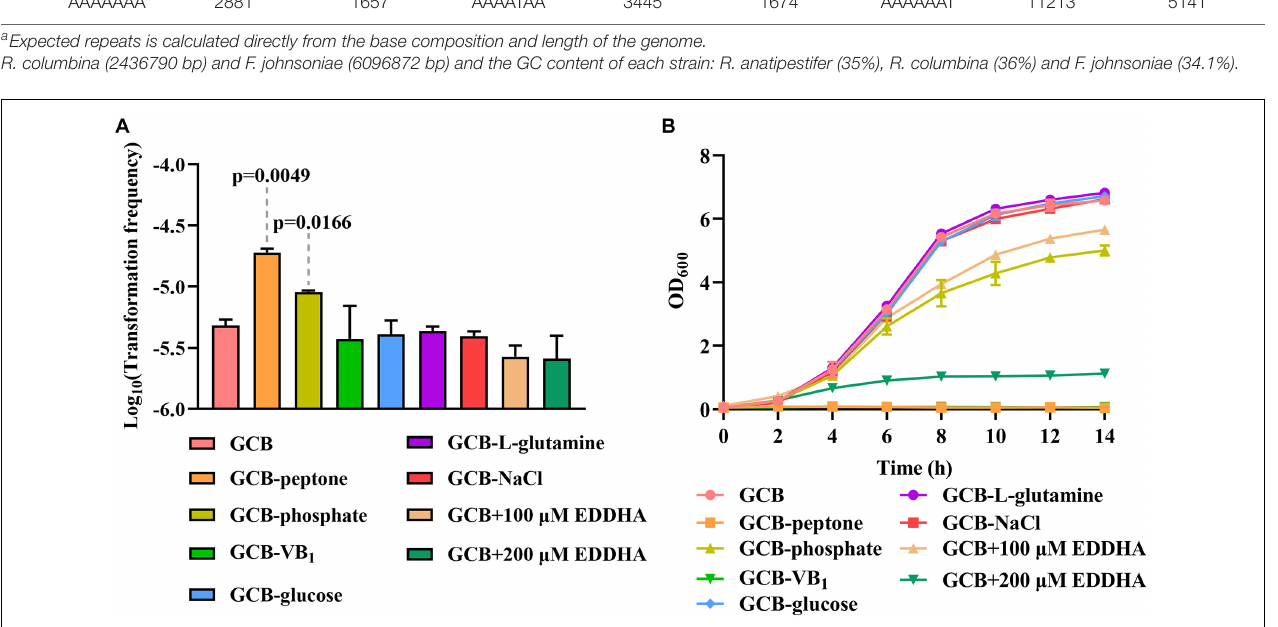
FIGURE 5 | The effect of GCB ingredients on natural transformation and growth in R. columbina . (A) TFs of R. columbina in GCB, GCB depleted of VB 1 , glucose, L-glutamine, NaCl, peptone or phosphate and GCB supplemented with different concentrations of EDDHA. The P -value refers to the difference between the TF in GCB and in GCB depleted of peptone or phosphate, respectively. Insignificance p -value ( P > 0.05) was not shown. (B) Growth curves of R. columbina in GCB, GCB depleted of VB 1 , glucose, L-glutamine, NaCl, peptone, or phosphate and GCB supplemented with different concentrations of EDDHA. The bacteria were cultured in 20 ml of the above medium inoculated at an OD 600 of 0.05, and the OD 600 value was determined every 2 h. All the results are representative of three independent experiments. Error bars denote standard